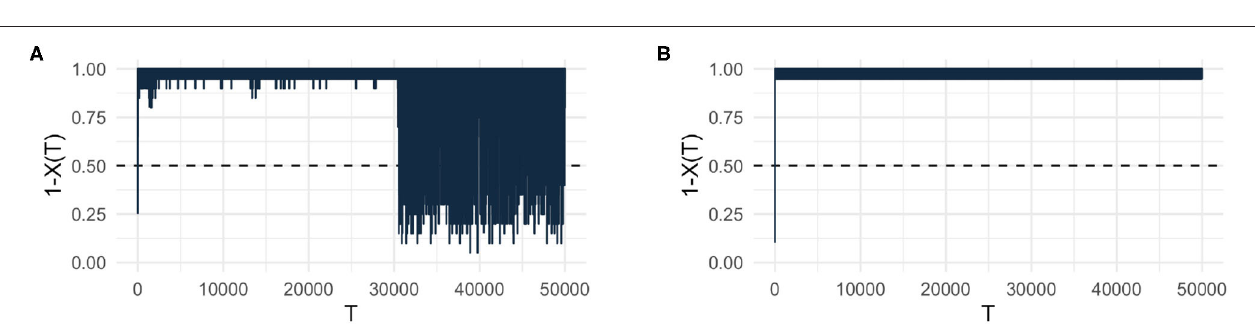
X ( T ), over time T for different interventions: (A) network intervention only, (B) network interventions and −